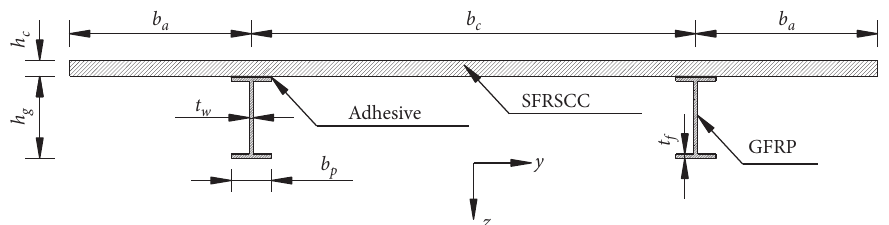
Figure 1: Cross-section of the two I-shaped GFRP with straight webs-concrete hybrid girder.